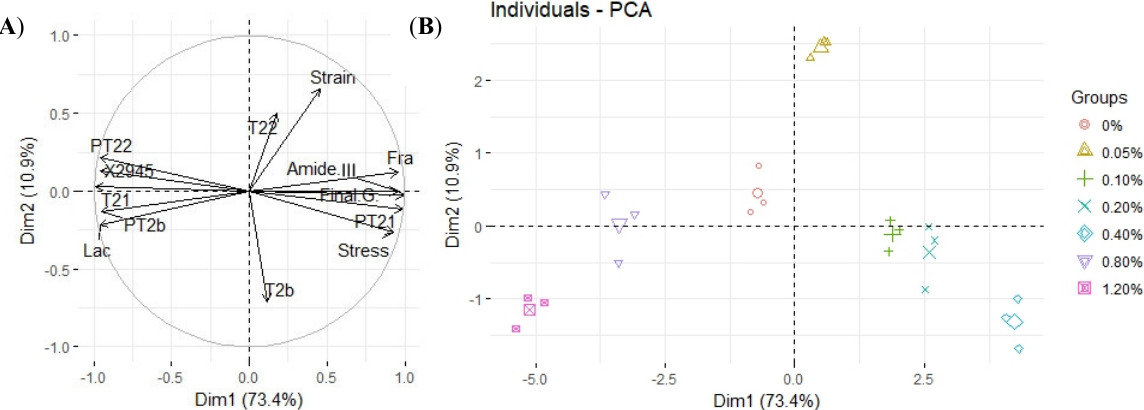
Figure 4. Principal component (PC) analysis loading plots in the plane of PC2 vs. PC1 ( A ). Results of the PCA score plots in the PC1 vs. PC2 plane ( B ).